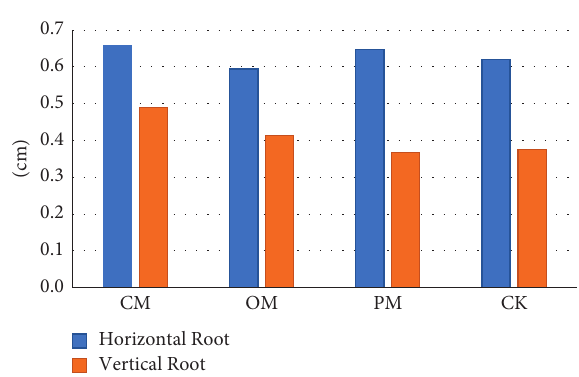
Figure 6: Horizontal and vertical root development.